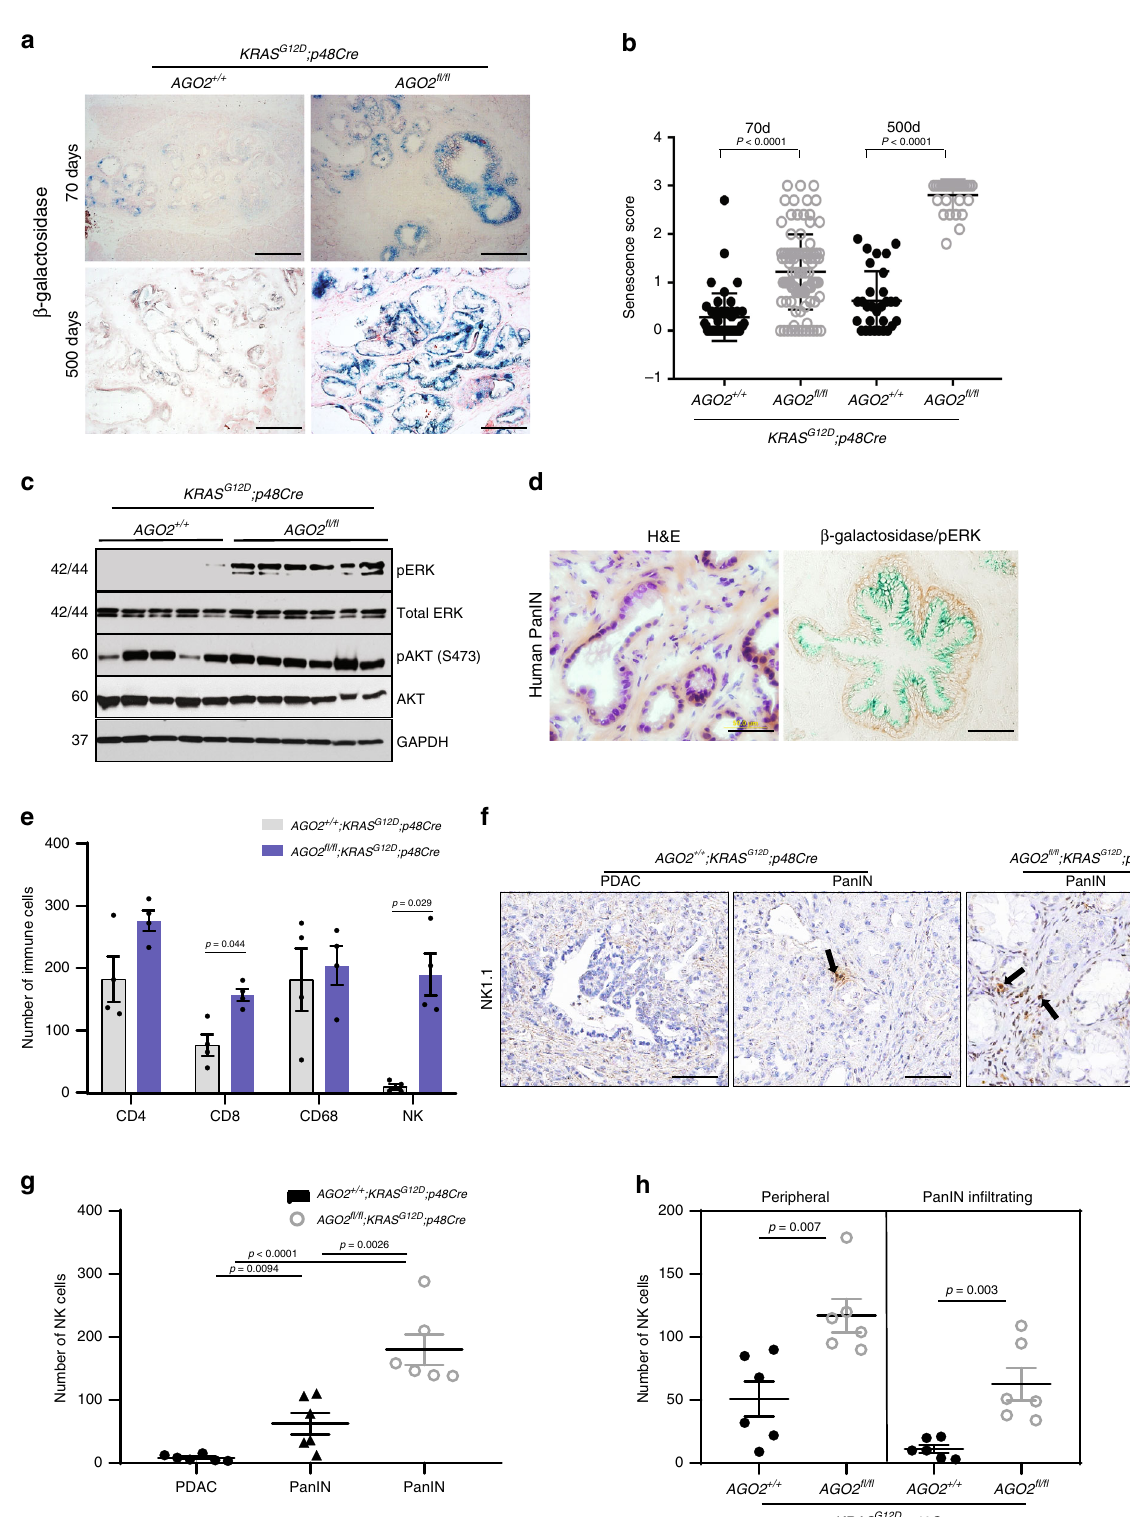
AGO2, with a low measure of co-staining pattern (Pearson ’ s correlation for co-localization, PCC = 0.1) (Fig. 5e). Interestingly, as shown in Fig. 5e, RAS expression increased in PanINs, which further increased in PDAC (Supplementary Fig. 7f). In a parallel manner, AGO2 expression progressively increased in PanIN and PDAC tissues (Supplementary Fig. 7g), with a concomitant increase in plasma membrane localization and co-staining